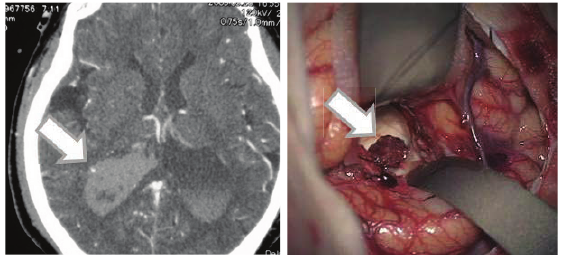
Figure 3. CT angiogram reveals the aneurysm is identified beside the lateral wall of the atrium arrow. Fig 3-2 Intraoperative Finding. The aneurysm (arrowhead) exists beside the lateral wall of the atrium (asterisk), opening the superior temporal sulcus.